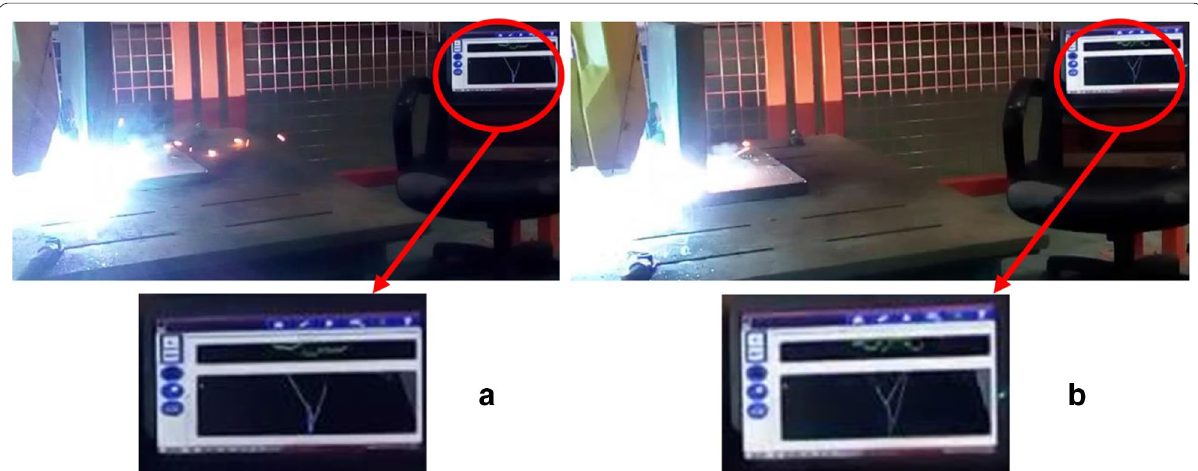
Figure 3 Example of influencing the automated welding process because of survival interference data points: a successful case in which all interference data points have been completely removed, b unsuccessful case in which fake feature points are identified because of the survival interference data points